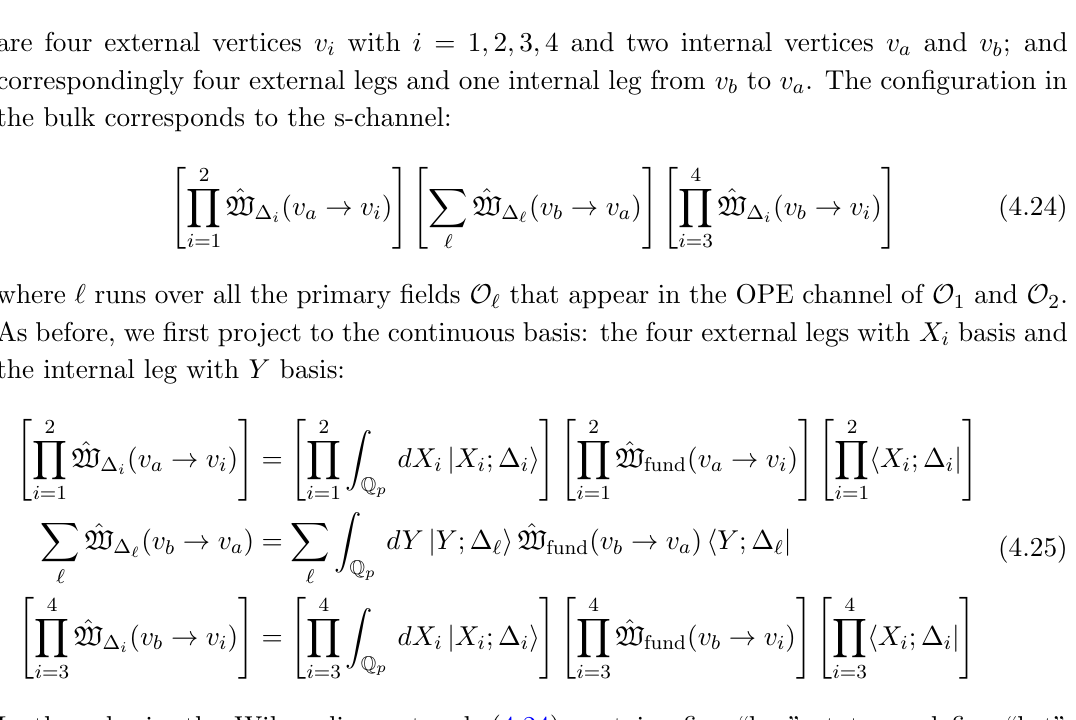
Figure 5 . A network of four Wilson lines with two intermediate